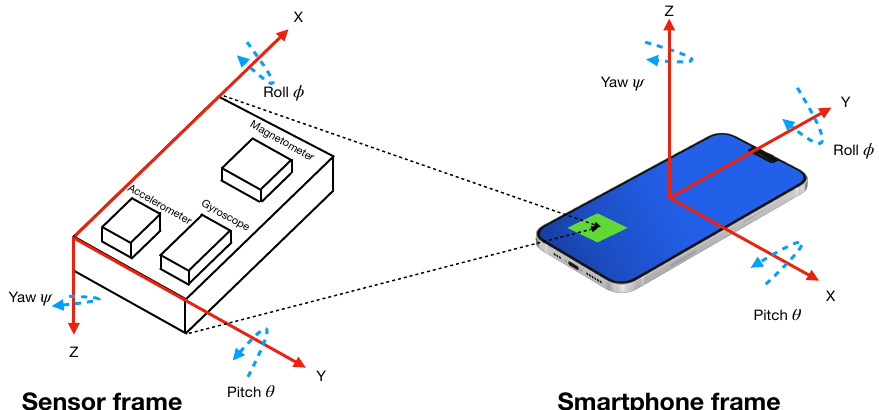
Figure 5. Android smartphone coordinate.